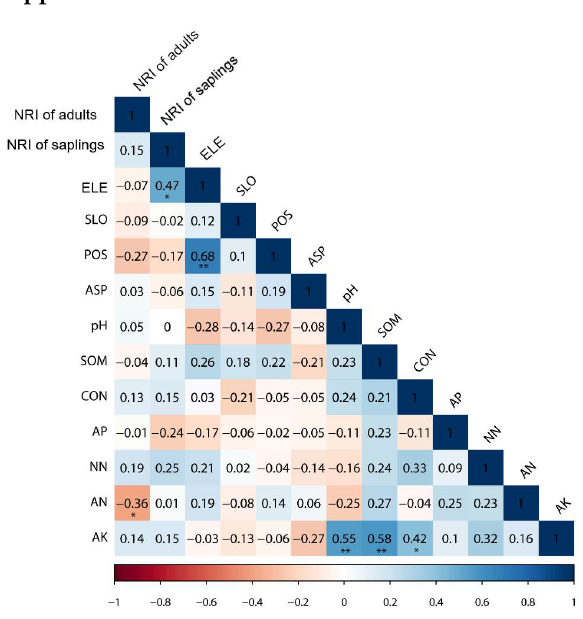
Figure A1. Results of Pearson’s correlation analyses of environmental factors and net